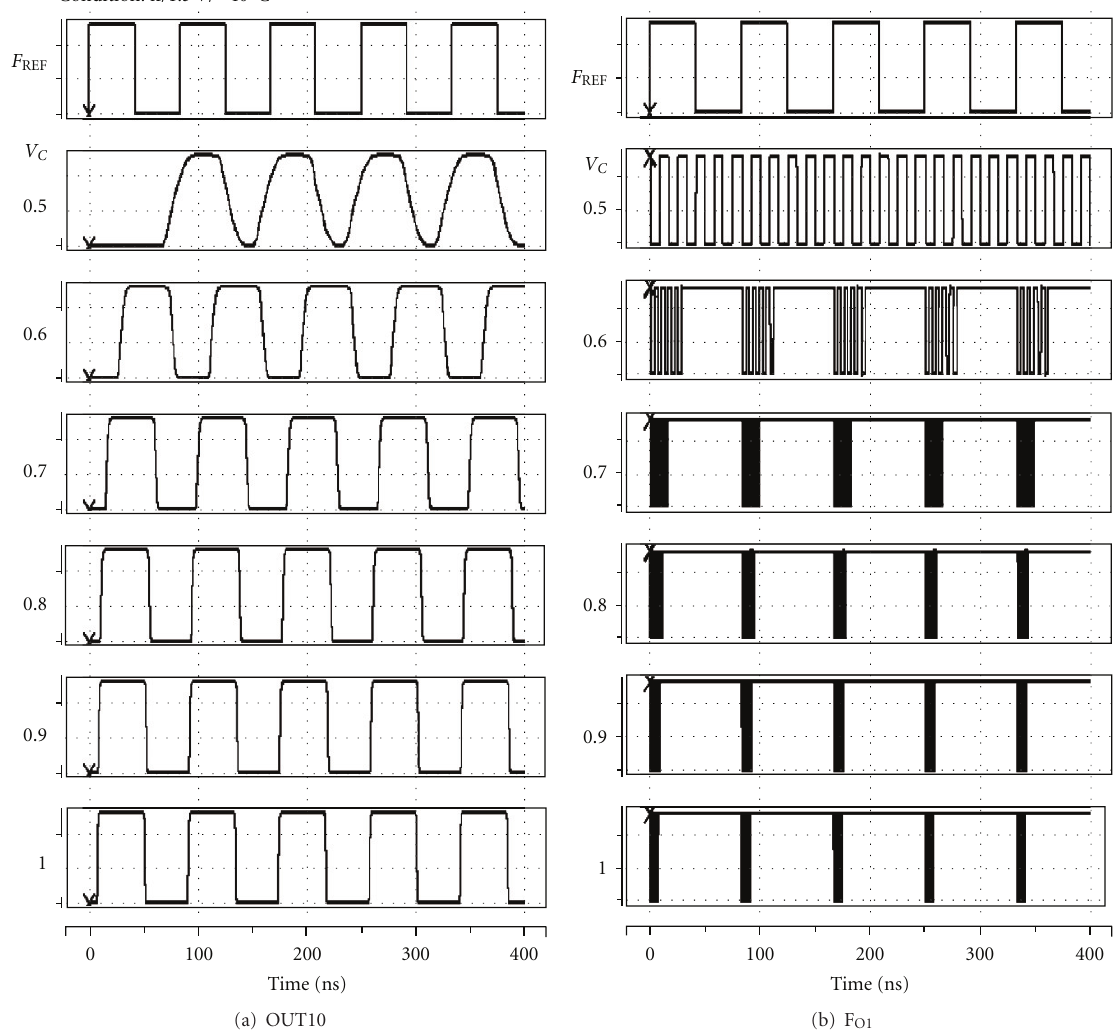
Figure 22: Postlayout simulation results from VCDL and EC applied to DLL1 for variable V C . The simulation condition is ff /1.30V/ − 40 ◦ C.